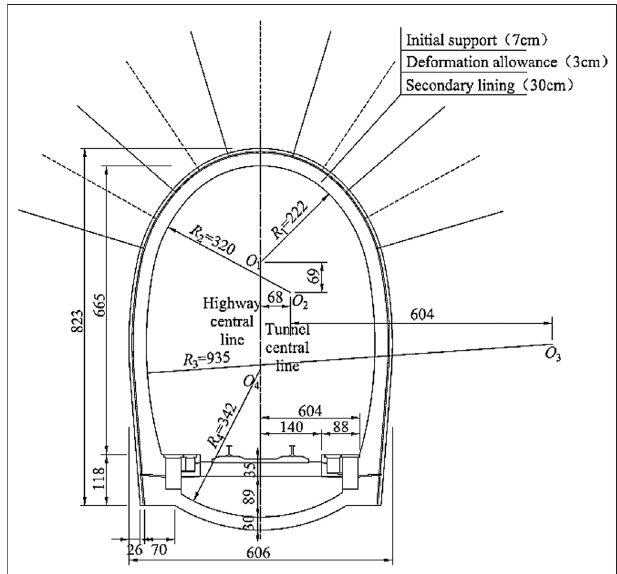
FIGURE 1 | Lining section of Taihangshan Mountain Tunnel (unit: